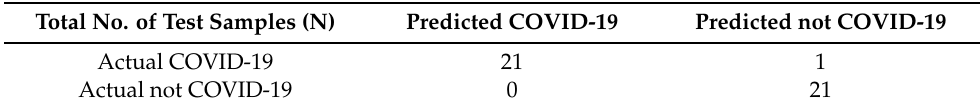
Table 3. Confusion matrix when test samples are 20% of the total dataset. Total No. of Test Samples (N)